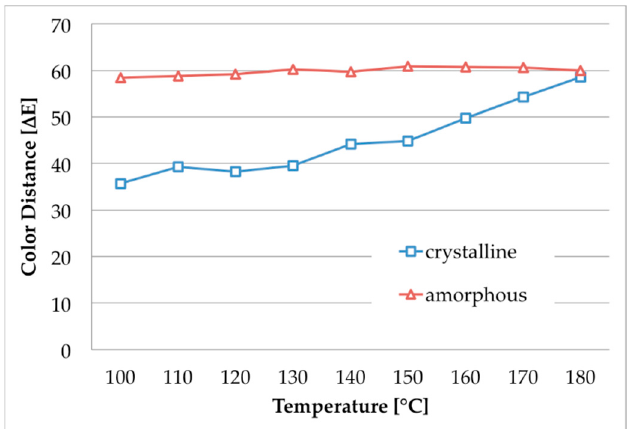
Figure 7. Color distances of amorphous and crystalline m-aramid fabrics after dyeing with Nigrosin in EMIM-EtSO 4 (temperature range 100–180 °C).